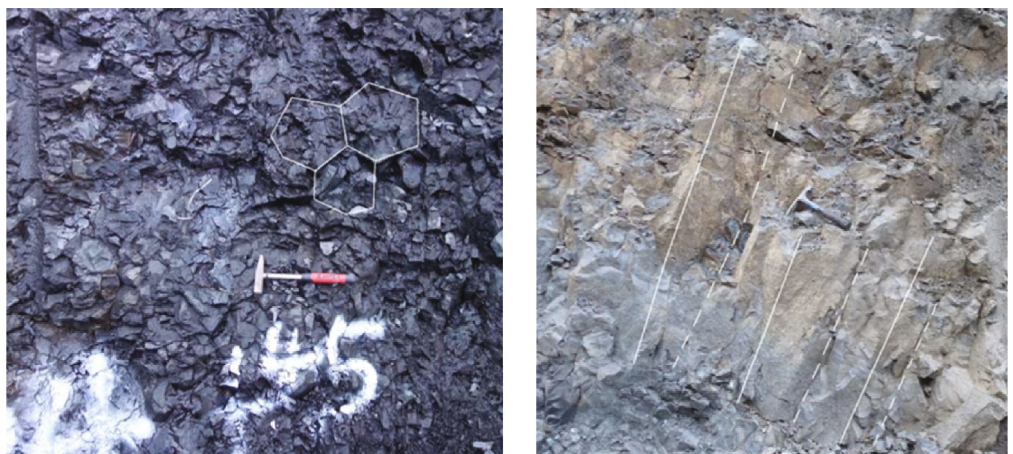
Figure 1: Small-scale columnar jointed basalt and weakly weathered columnar jointed basalt